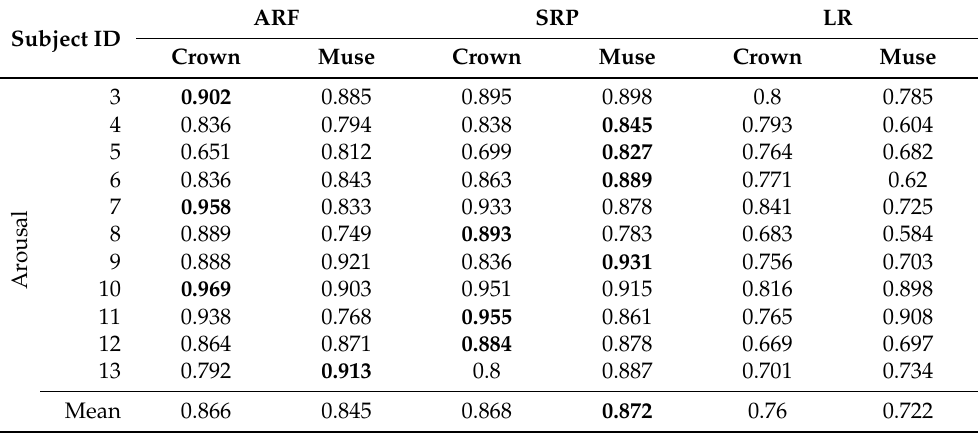
Table 4. Comparison of mean F1-Scores of Arousal and Valence recognition per participant and device from Dataset I with three classifiers using progressive validation. Bold values indicate the best-performing model per participant and dimension. The mean total represents the calculated average of all models’